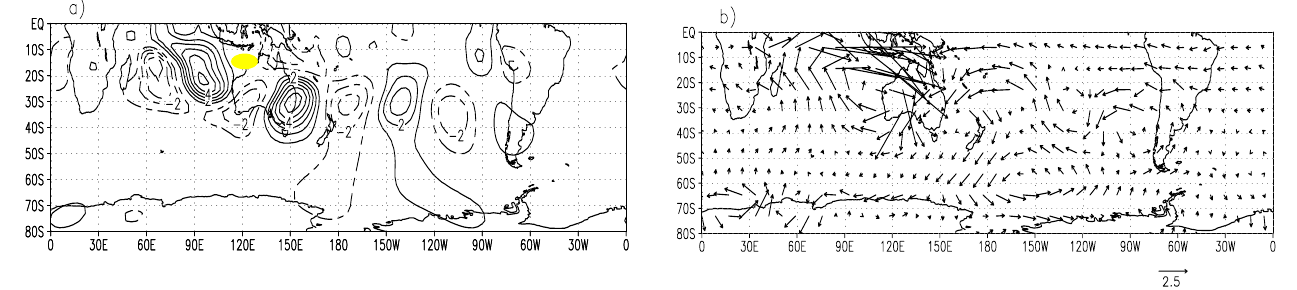
Figure 9 : Meridional wind component anomalies (ms -1 ) at 250 hPa (a) and wind vector anomaly at 850 hPa (b), on day 10 of integration, corresponding to the mean winter basic state experiment with the forcing at 120ºE-15ºS (see gray dot in the figure)